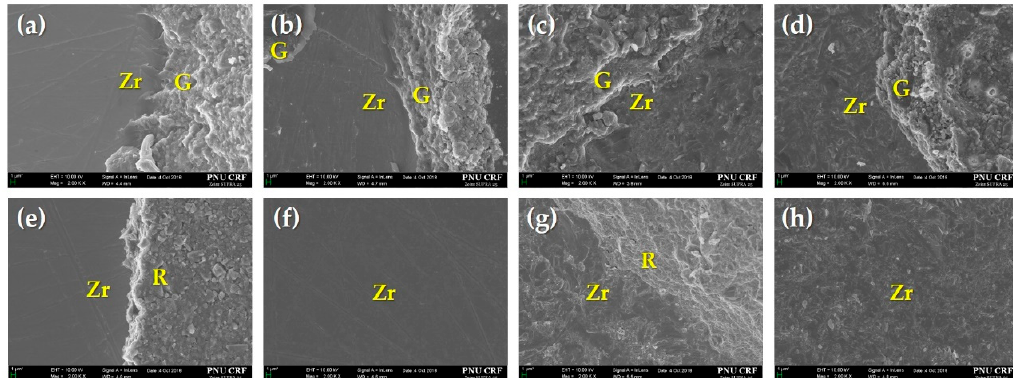
Figure 9. Representative FE-SEM images (2000×) of the Y-TZP surface in each group with thermocycling after the SBS test. ( a ), ( b ), ( c ), and ( d ) represent the Control, NTP, Sb, and Sb + NTP groups of G-CEM LinkAce, respectively; ( e ), ( f ), ( g ), and ( h ) represent the Control, NTP, Sb, and Sb + NTP groups of RelyX U200, respectively. ( a ), ( b ), ( c ), ( d ), ( e ), and ( g ) show mixed failures; ( f ) and ( h ) show adhesive failures. Zr, Y-TZP surface; G, fractured surface of G-CEM LinkAce; R, fractured surface of RelyX U200.